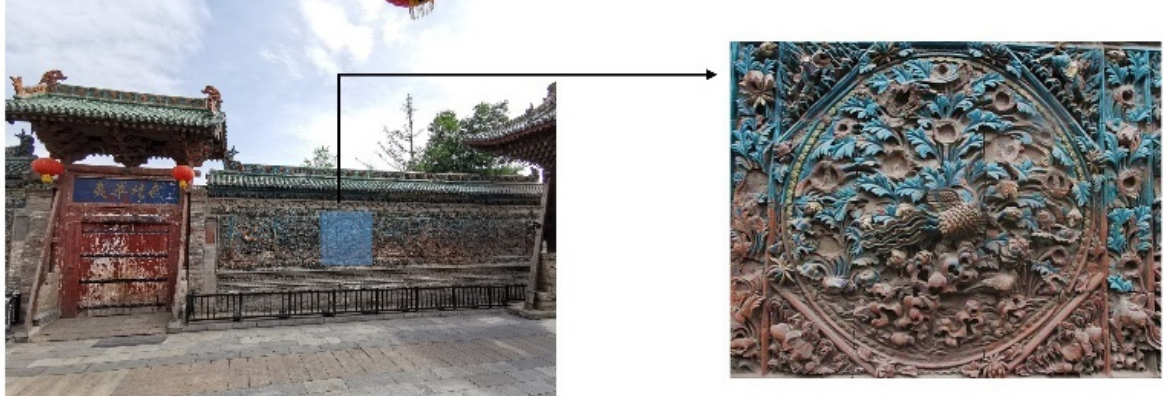
Figure 3. Screen walls with glazed tile decoration in the Hancheng Confucian Temple building complex.